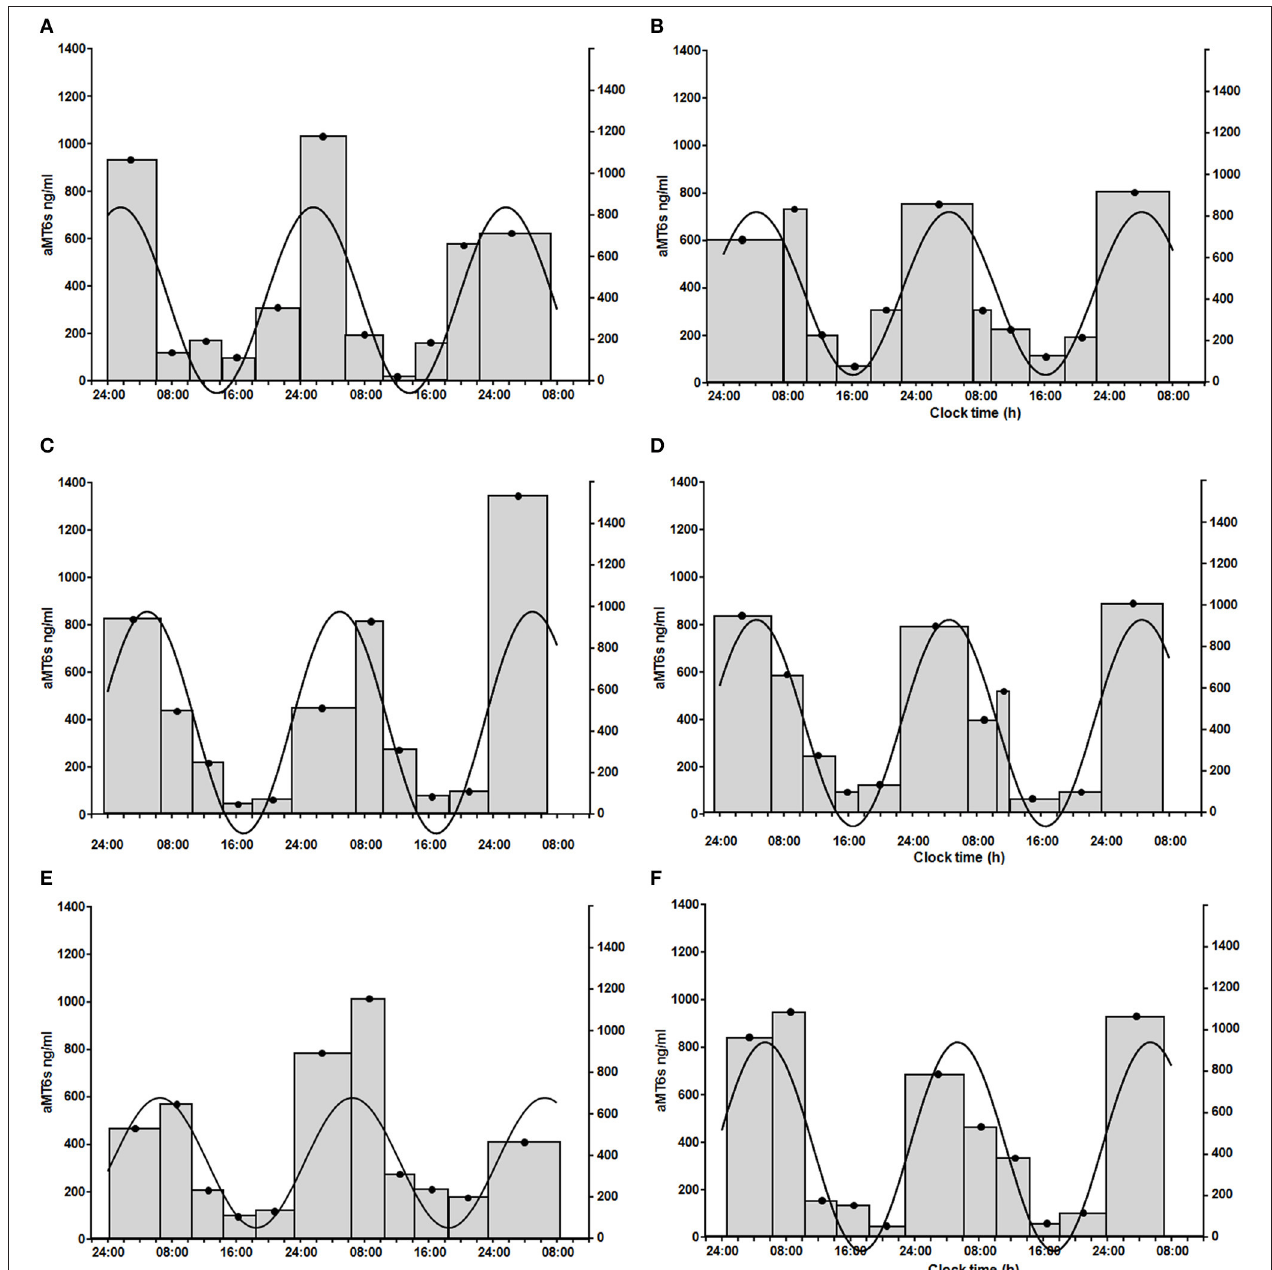
FIGURE 4 | Sequential 56-h (three nights and 2 days) aMT6s excretion (ng/h, gray histograms, left y axis; width of the histogram = time between first and last bladder emptying over the collection period) in a healthy volunteer [female, 73 years of age; prior to (A) and after light administration (B) ], a patient with primary biliary cholangitis [female, 65 years of age; prior to (C) and after light administration (D) ], and a patient with cirrhosis [female, 50 years of age; prior to (E) and after light administration (F) ]. Urinary aMT6s concentrations are high during night sleep and low during the waking day. Continuous line: fitted cosinor function, which shows the profile of urinary aMT6s concentrations over the 24-h period and allows calculation of a set of cosinor-derived aMT6s parameters (right y axis: amplitude of the cosinor fit in ng/h of aMT6s). In all three participants the cosinor fit was significant both at baseline and after light administration, the fit improving considerably after light administration. Healthy volunteer: % rhythm: 77; p = 0.003 at baseline (A) and % rhythm: 91; p < 0.0001 after light administration (B) ; patient with primary biliary cholangitis: % rhythm: 59; p = 0.028 at baseline (C) and % rhythm: 95; p < 0.0001 after light administration (D) ; patient with cirrhosis: % rhythm: 60; p = 0.026 at baseline (E) and % rhythm: 88; p < 0.001 after light administration (F)